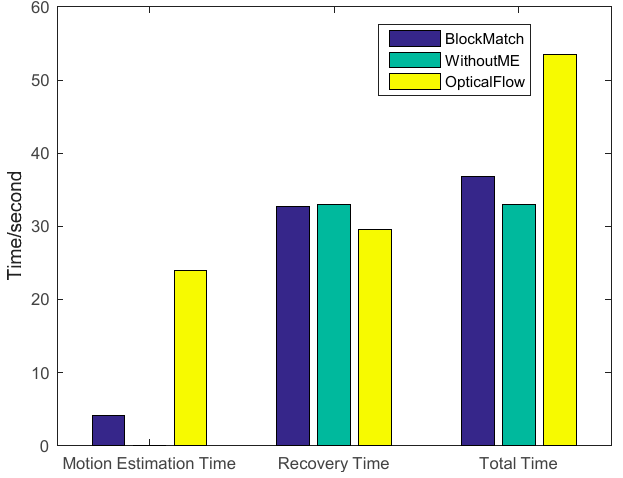
Figure 15. Time cost of the images recovered by our block matching scheme, the optical flow and without motion estimation (WithoutME).